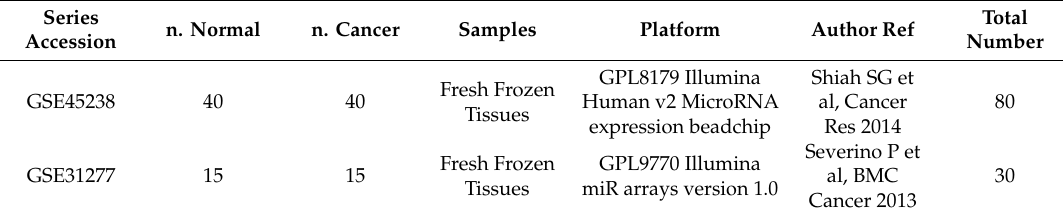
Table 7. Features of the two selected datasets from GEO